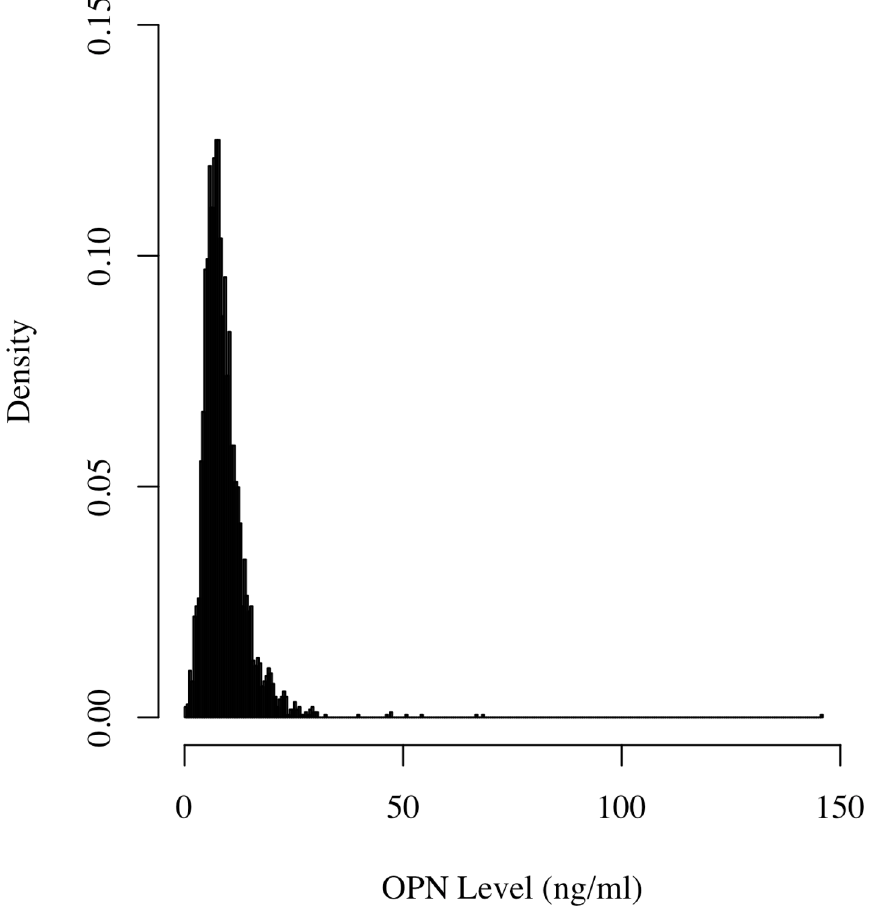
Fig 1. Histogram of OPN levels in 3567